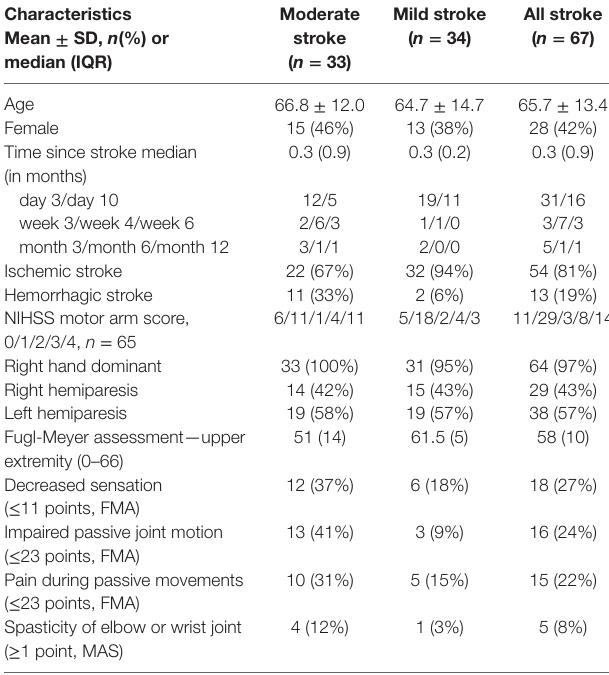
TaBle 1 | Demographic data and clinical characteristics of individuals with